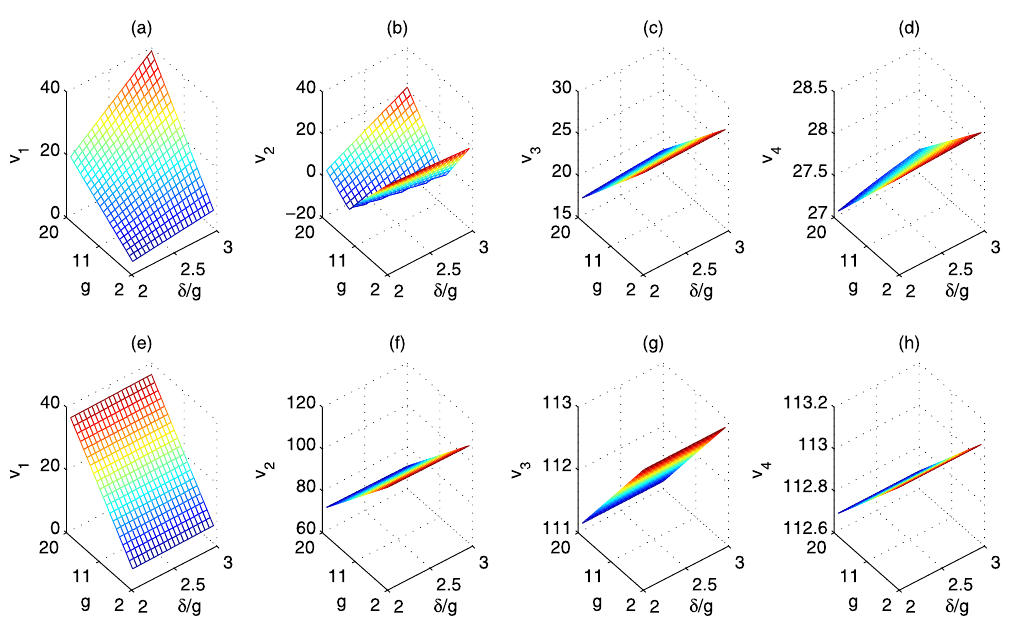
Figure 6. The adiabatic conditions vias δ / g and g . ( a – d ) Denote the first case in Fig. 4. ( e – h ) Denote the second case in Fig. 4. Here, v 1 = δ − λ